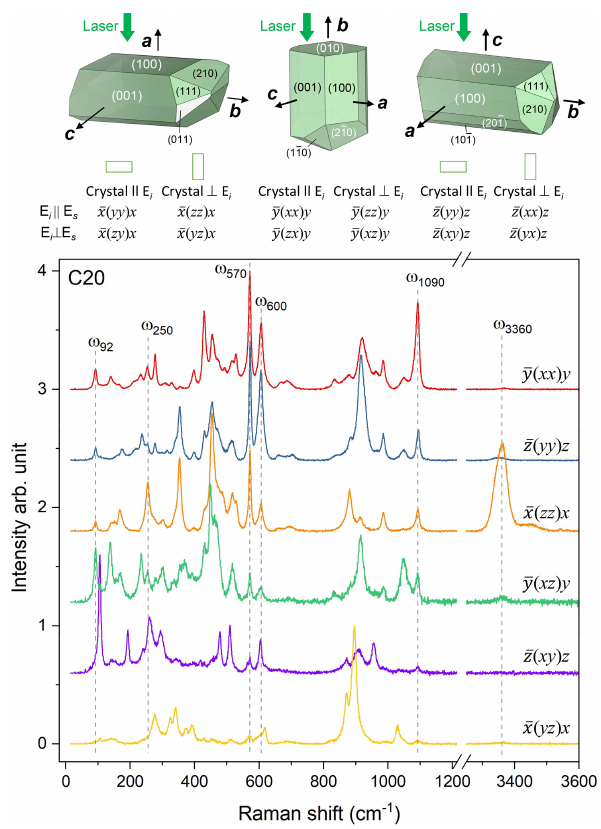
Figure 4. Polarized Raman spectra collected in six different geome- tries from euhedral single crystals of sample C20, along with crystal habits typical of epidote-group minerals as well as the relationship between the crystal orientation and the scattering geometry. Peaks further discussed in the paper are marked by dashed lines. Crystal shapes were drawn with VESTA 3 (Momma and Izumi, 2011).